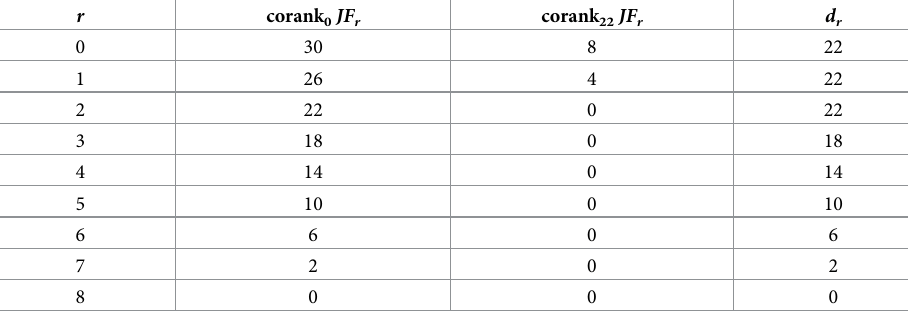
Table 9. Summary of computations showing model is